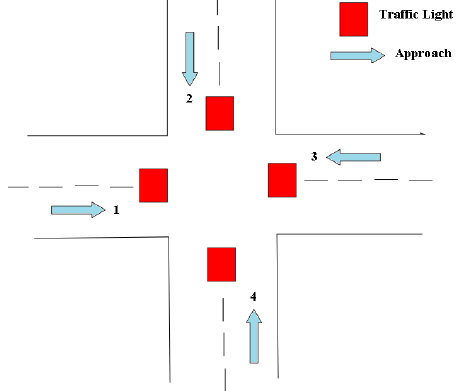
Figure 1. TrafficIntersection with approaches